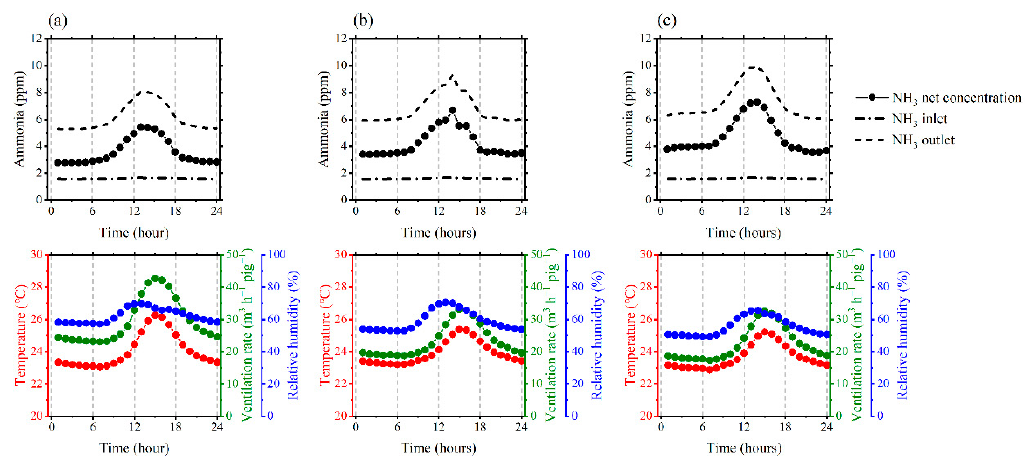
Figure 4. Diurnal graphs of ammonia concentration (top), room temperature, ventilation rate, and room relative humidity (bottom) in ( a ) Room A, ( b ) Room B, and ( c ) Room C.